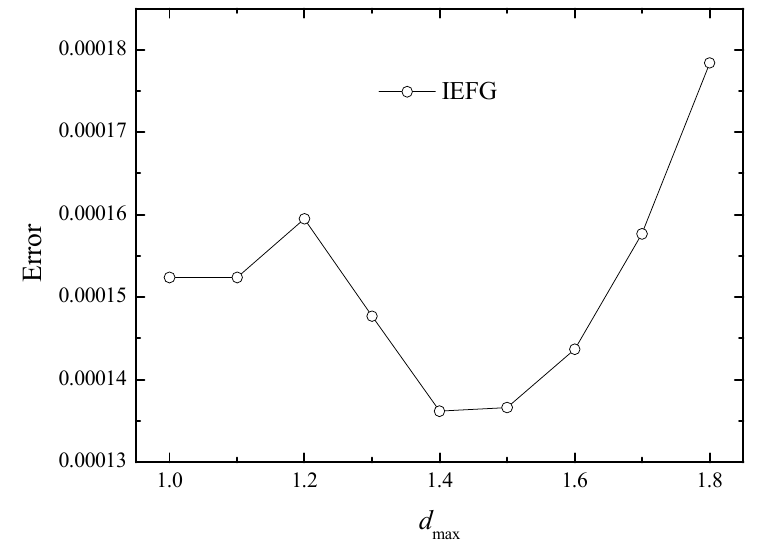
Figure 1. The relationship between d max and the relative error.